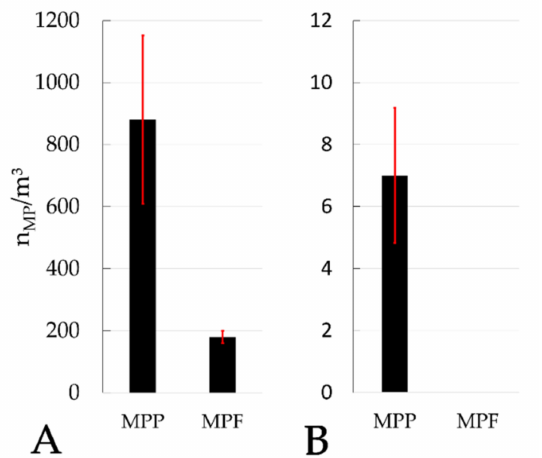
Figure 4. Average number of identified microplastic particles (MPP) and microplastic fibers (MPF) of samples 1–3 in treated wastewater of Mannheim WWTP in final clarifier effluent ( A ) and sand filter effluent ( B ).